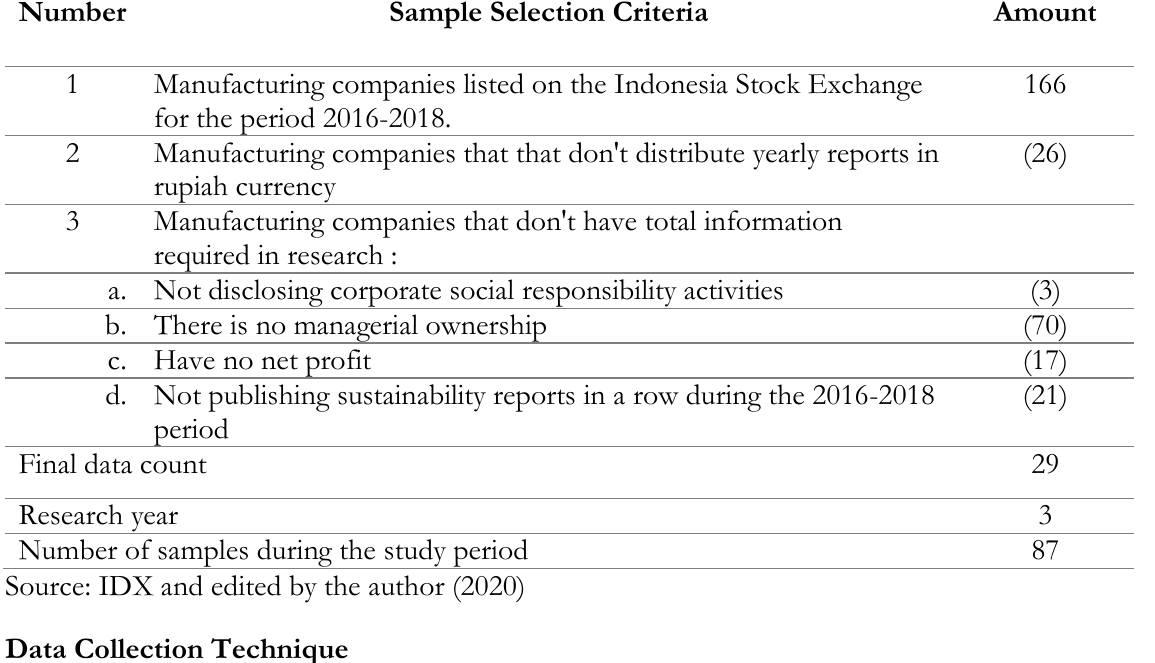
Sample Selection Process